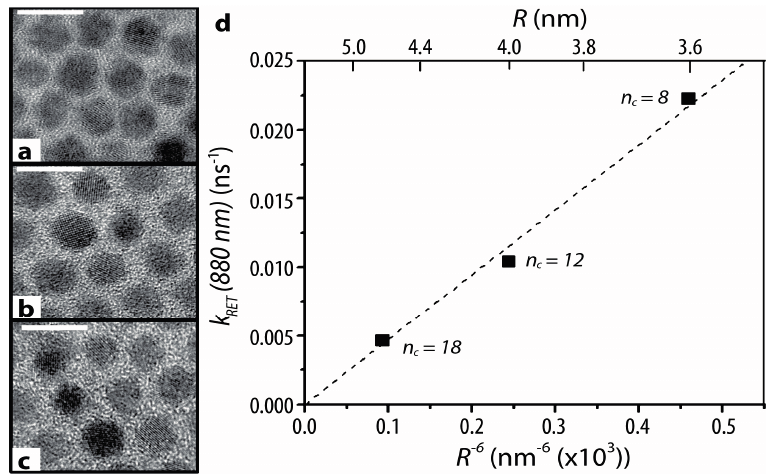
Figure 8. PbS dots with ( a ) C8 ( b ) C12 and ( c ) C18 ligands corresponding to average surface-to-surface separations of 1.0 ± 0.2, 1.4 ± 0.5, and 2.1 ± 0.5 nm, respectively. Scale bars are 10 nm on all images; ( d ) The rate of non-radiative resonance energy transfer (RET) as a function of the sixth root of the interdot distance with the corresponding center-to-center interdot distance on the upper axis. Reproduced with permission from [73]. Copyright (2011) American Chemical